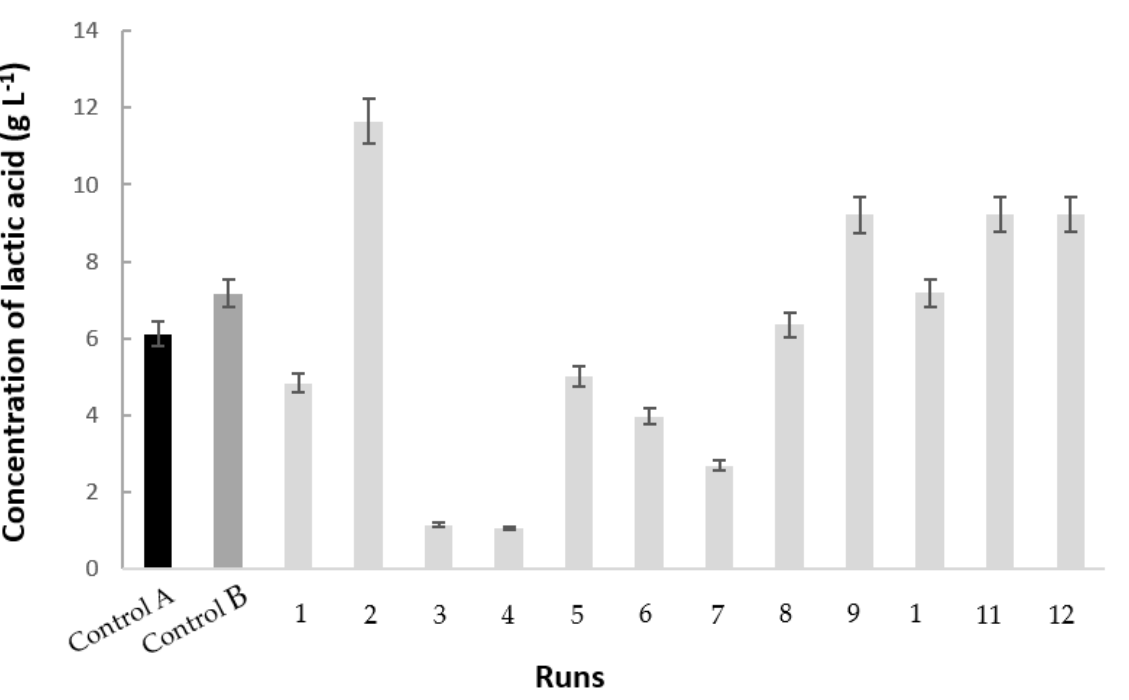
Figure 3. Lactic acid production by P. pentosaceus TCC 43200 during cultivations in MRS broth in for 24 h. A = Control A ( ■ ); B = Control B ( ■ ); runs 1-12 ( ■) . For conditions of runs and controls see Table 3. Main experimental results of P. pentosaceus ATCC 43200 cultivations related to substrate consumption and lactic acid formation. Values were collected after 24 h of fermentation.